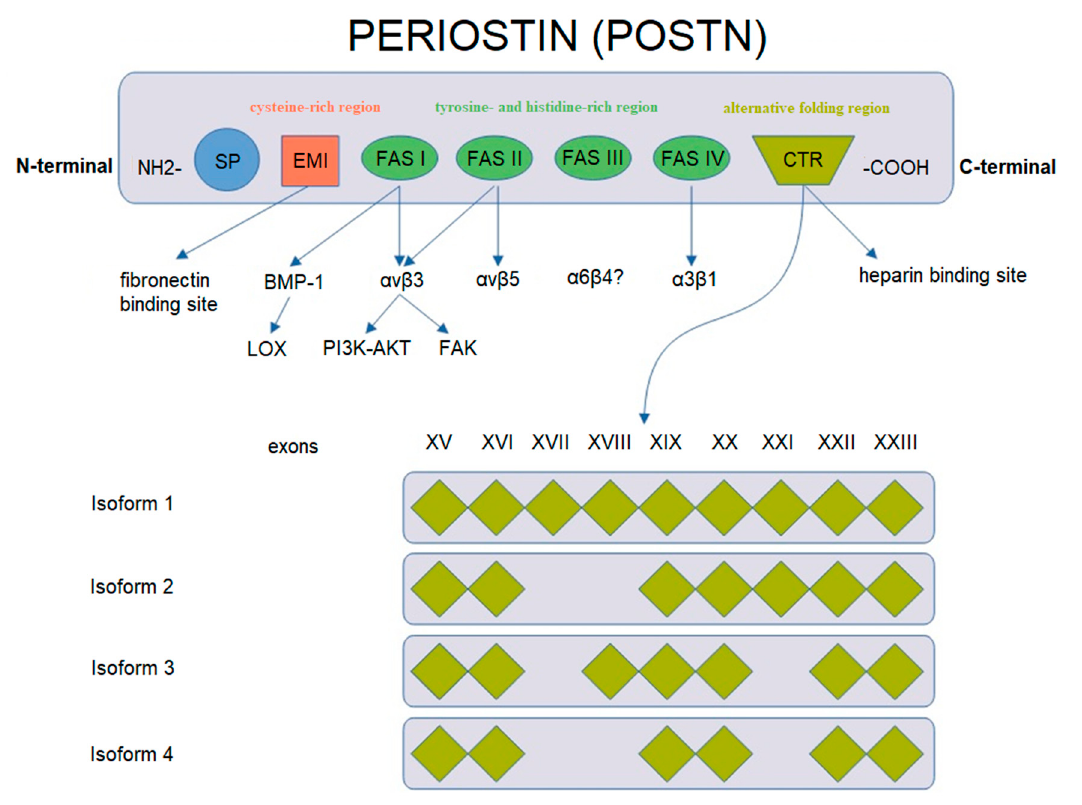
Figure 2. Schematic representation of POSTN gene structure and protein isoforms (based on Nuzzo et al. [43], modified).